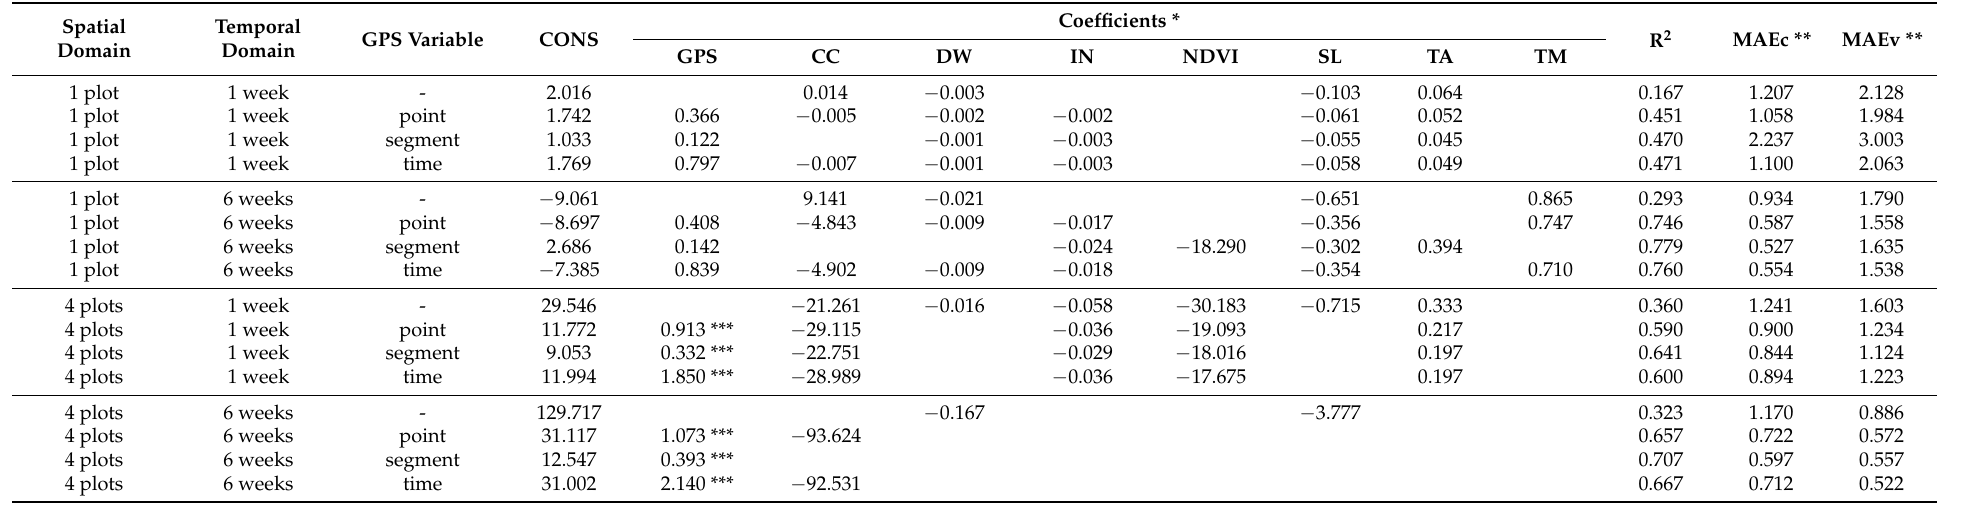
Table 3. Prediction models validated in the spatial